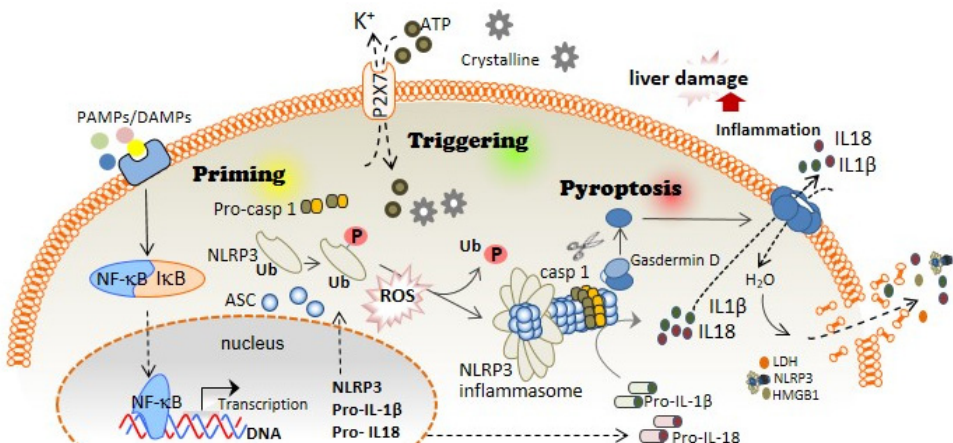
Figure 1. NLRP3 inflammasome and pyroptosis activation induces liver damage . The canonical activation of the NLRP3 inflammasome is differentiated in two steps: priming and triggering. Priming; PAMPs and DAMPs stimulate TLR and other receptors, which induce the NF- κ B translocation to the cell nucleus, thus increasing the expression of the different inflammasome components: NLRP3, pro-IL-1 β , and pro-IL-18 expression. During priming signaling, NLRP3 also undergoes different post-translational modifications that facilitate its activation, including phosphorylation/dephosphorylation and de-ubiquitination. Triggering; DAMPs such as extracellular ATP or crystalline structures induce the activation of the NLRP3 inflammasome oligomer, which leads to the activation of Caspase-1. Caspase-1 cleaves Gasdermin D in addition to pro-IL-1 β and pro-IL-18, which turn into mature IL-1 β and IL-18. Pyroptosis; The N-terminal fragment of Gasdermin D generated after Caspase-1 cleavage forms oligomeric pores in the plasma membrane allowing the release of pro-inflammatory cytokines such as IL-1 β and IL-18 into the extracellular space. Additionally, Gasdermin D pores lead to water influx into the cell, cell swelling, and cell lysis mediated by the ninjury-1 protein, thus increasing the inflammatory response by releasing inflammatory products from the intracellular